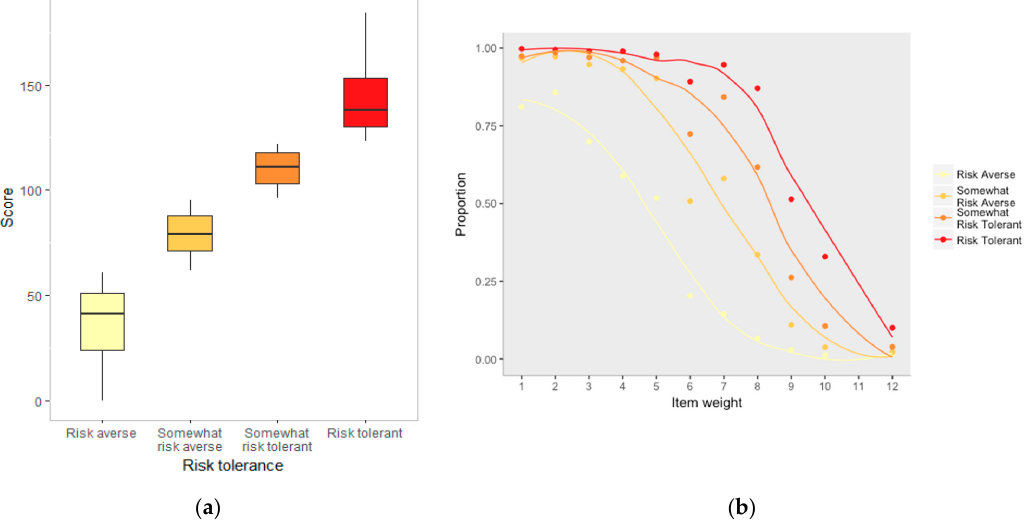
Figure 2. Results from the Tolerance for Risk in Play Scale (TRiPS) ( a ) Scores associated with each